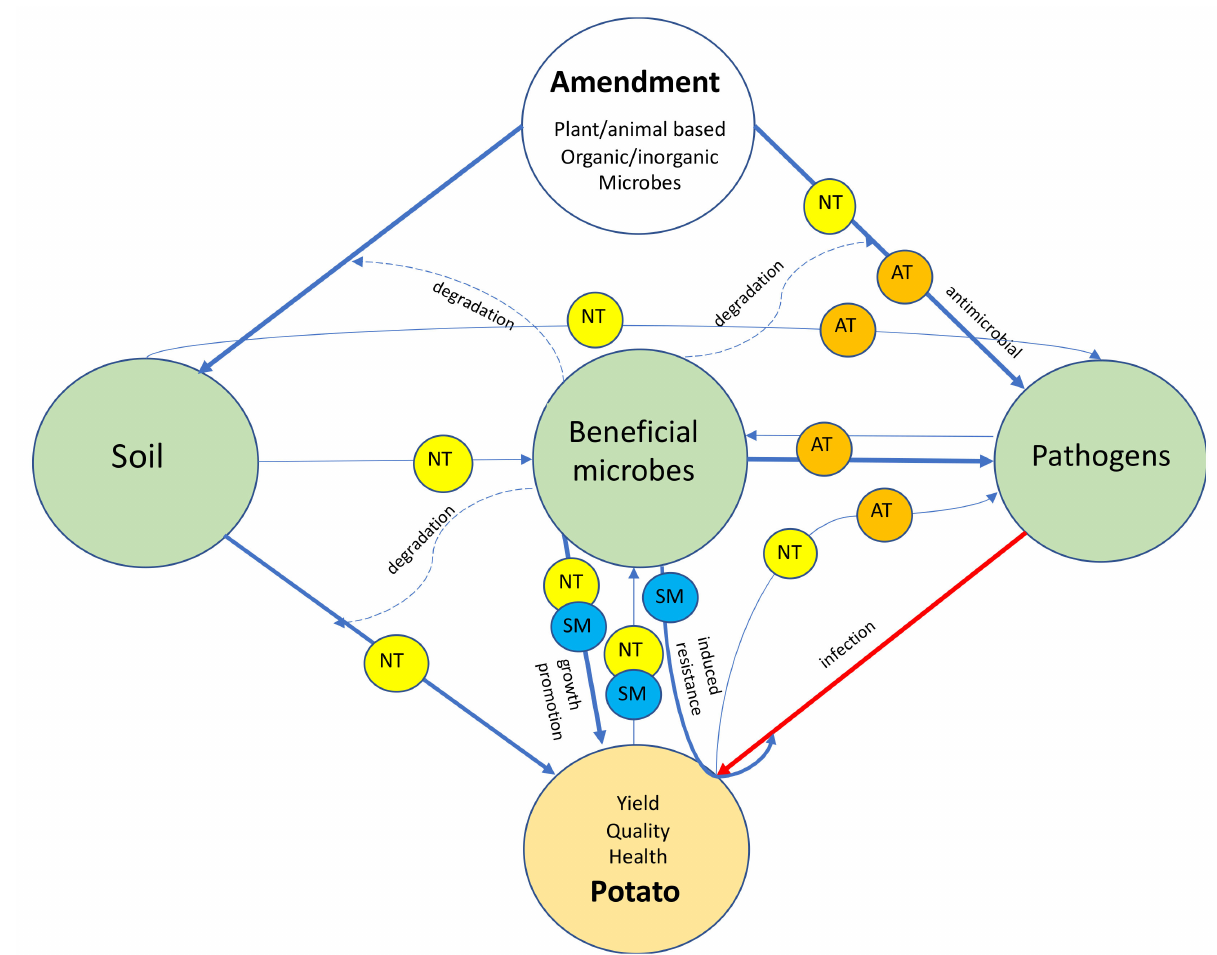
Figure 1. Schematic diagram showing the relationships among potatoes, soil, soil microbiome (beneficial microbes and pathogens) and soil amendments, placed in larger circles. Various compounds (small circles) are produced from corre- sponding materials, represented by antimicrobial substances (AT); small molecules (SM such as enzymes, proteins, signal molecules, toxins, hormones, volatile organic compounds, etc.), and nutrients (NT). Solid lines in blue with arrows indicate activities by providing key materials, and level of activity is measured by the width of the line. The red solid line indicates plant infection caused by soilborne pathogens. Dashed lines indicate a biological process of materials in the